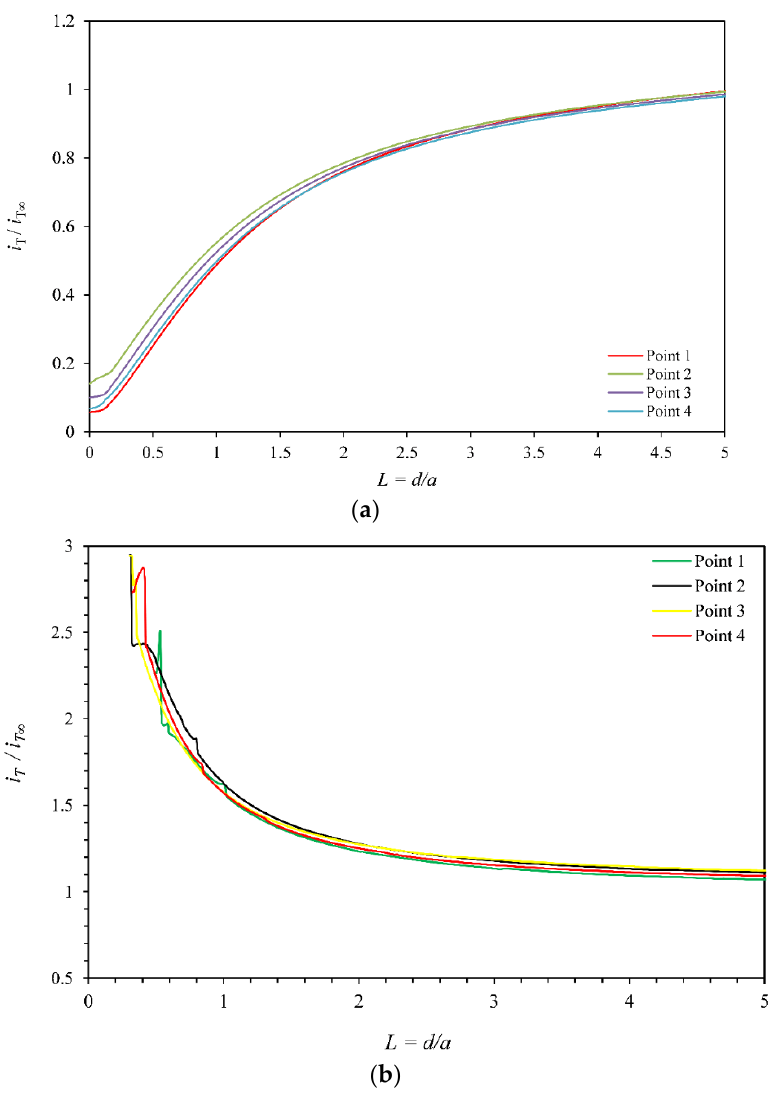
Figure 11. Current distance curves recorded in droplet of 0.5 M K 2 SO 4 containing 1 mM FcOH as